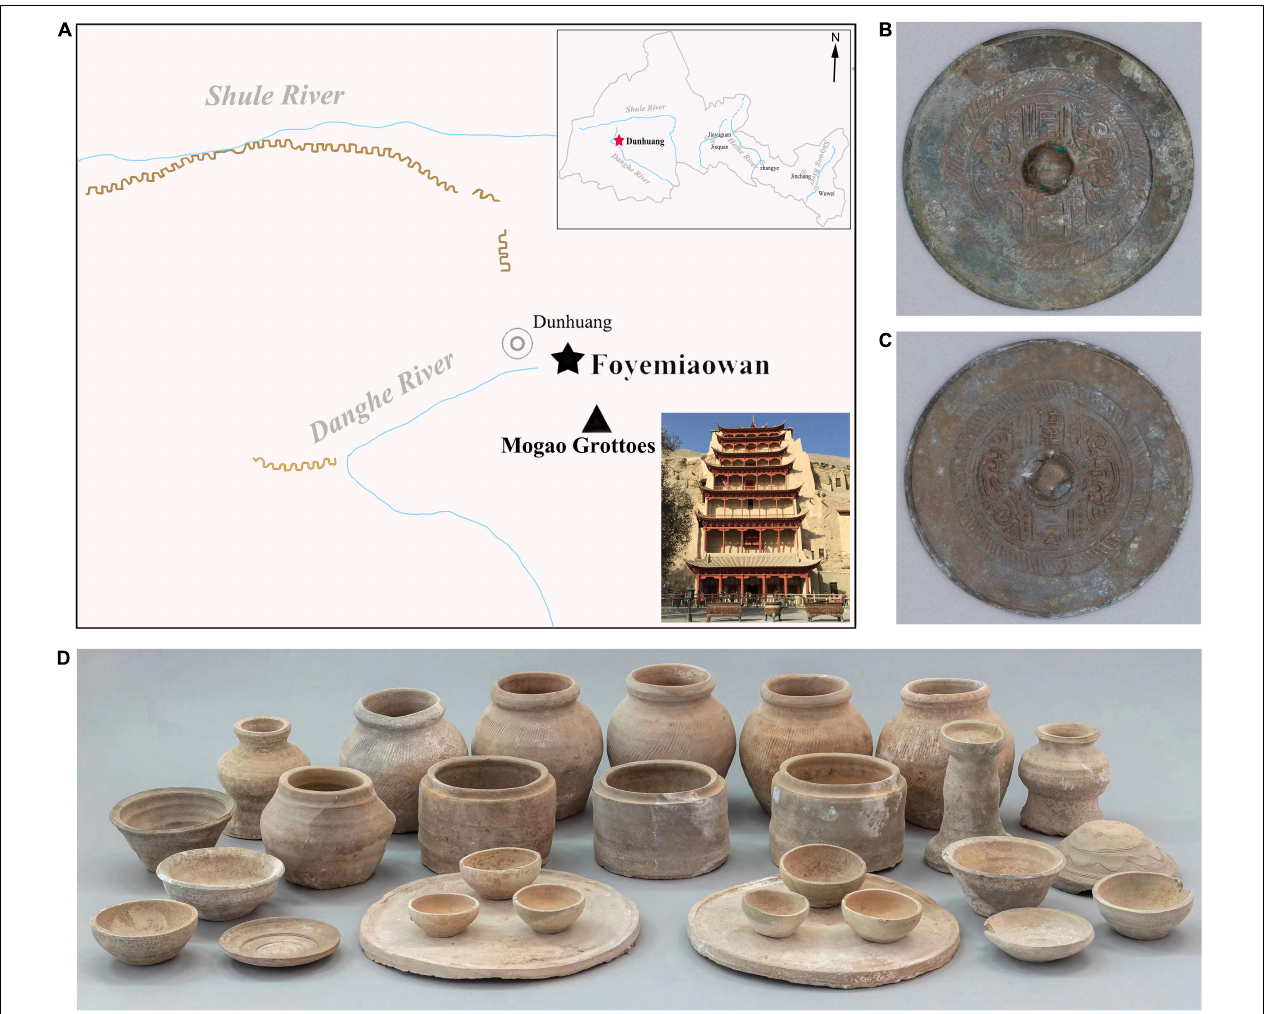
Table 2A . Principal component analysis (PCA) was performed using a prcomp () function of R. Visualization of PCA results